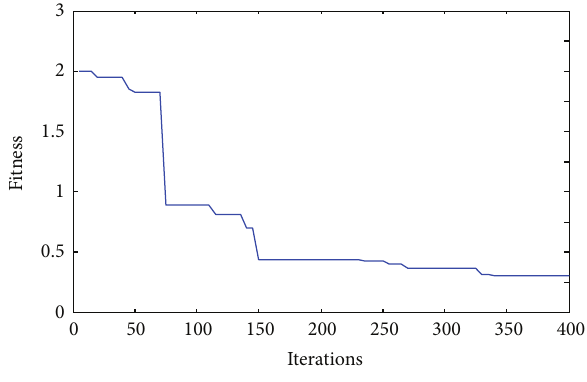
Figure 5: Convergence of QGA.